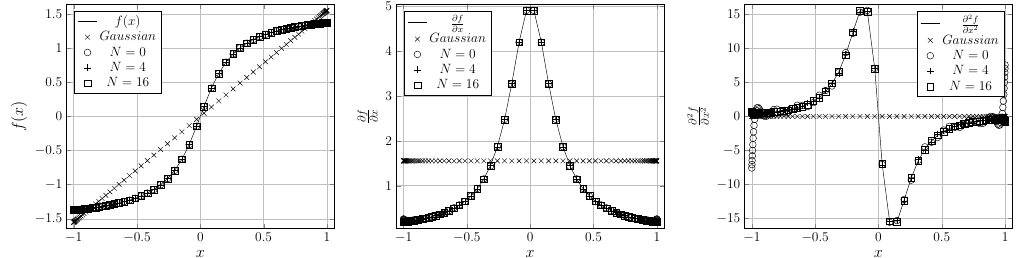
Figure 1. Comparison between the Gaussian radial basis function (RBF) and proposed Hermite expansion of the RBF for approximating the one-dimensional model equation and its